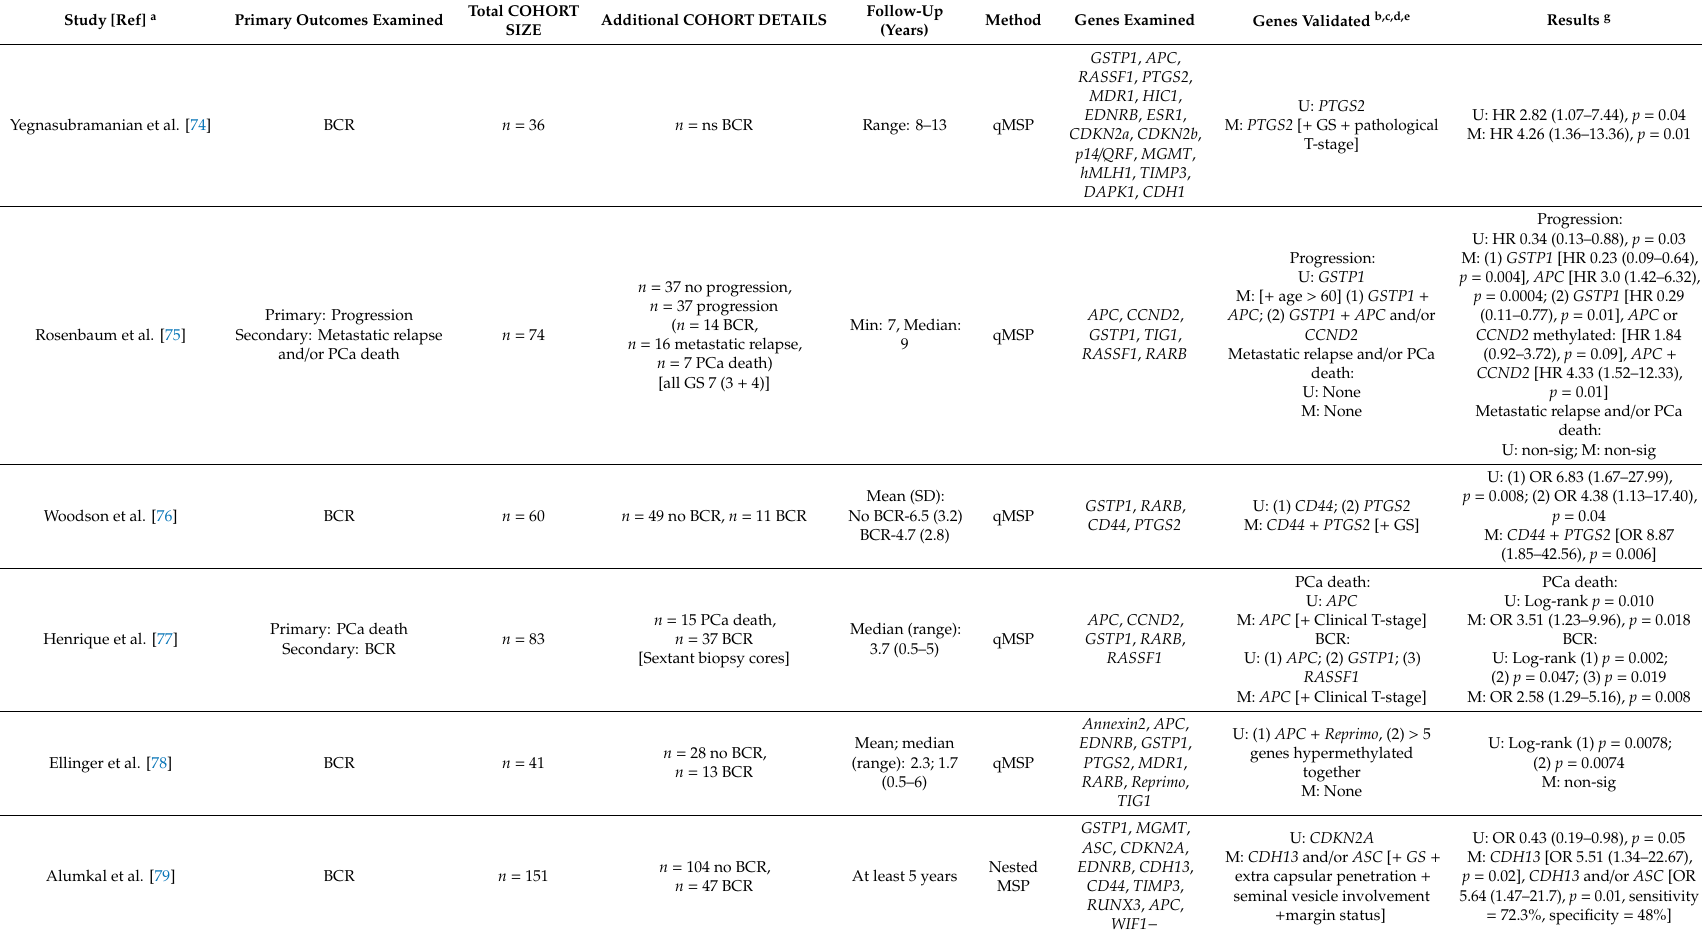
Table 1. Candidate (a priori) prognostic methylated tissue-based biomarker